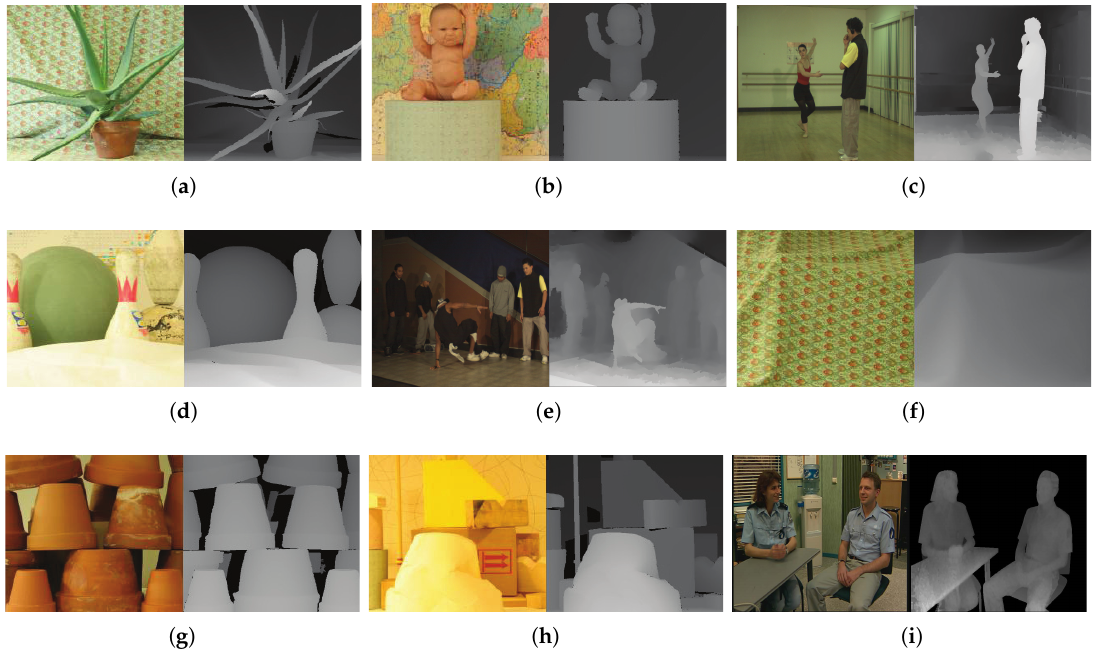
Figure 10. Test image sets. ( a ) Aloe; ( b ) baby; ( c ) ballet; ( d ) bowling; ( e ) breakdancers; ( f ) cloth; ( g ) flowerpot; ( h ) lampshade; ( i ) interview.